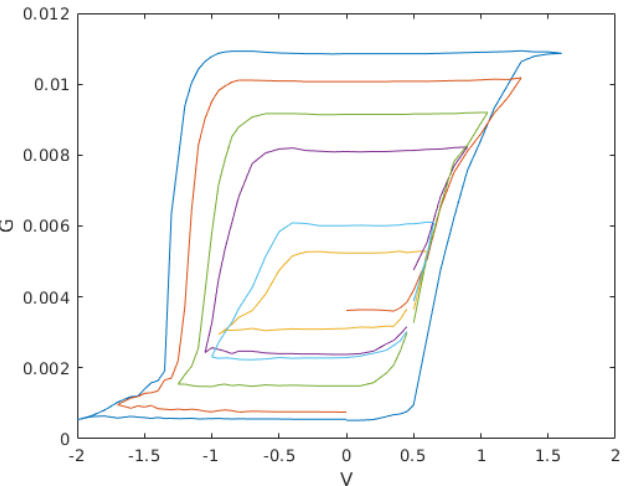
Figure 2. Measured values of the conductance G (in S), for different amplitudes of the applied input